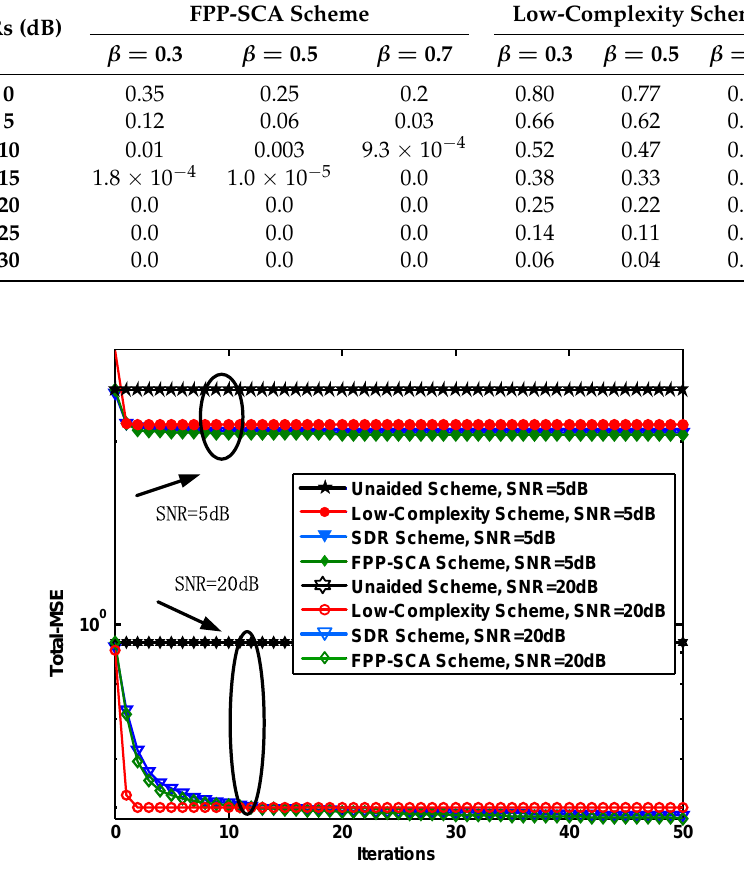
Figure 3. The total mean square error (total-MSE) versus the iterations for N = M =